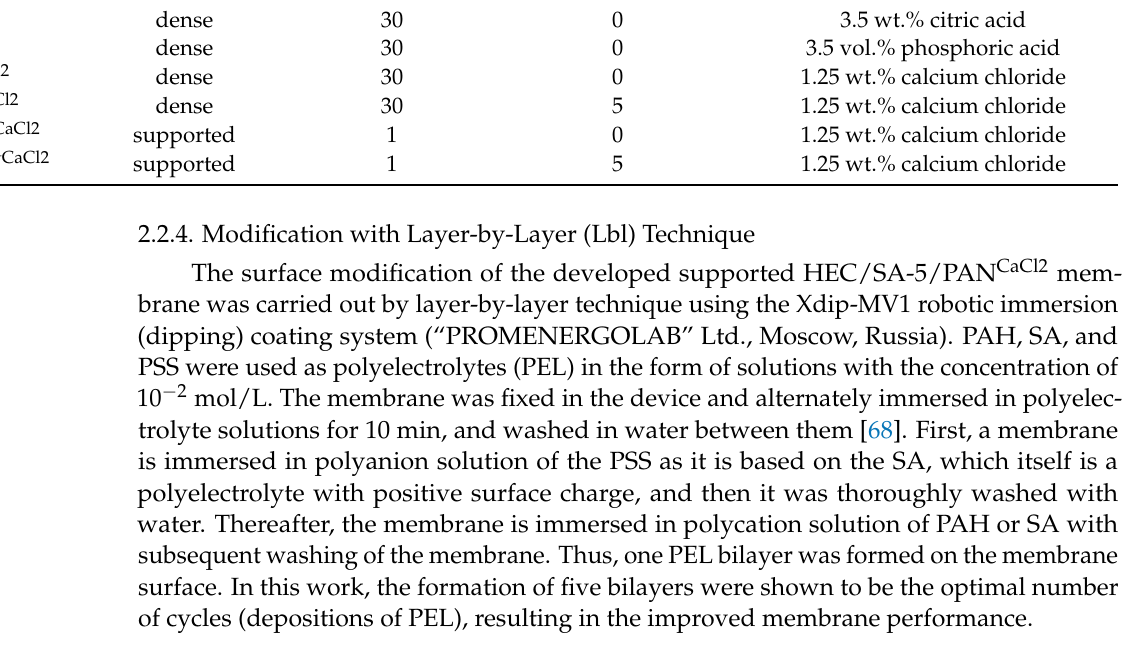
Content of Cross-Linking C 60 (OH) 22–24, wt.%